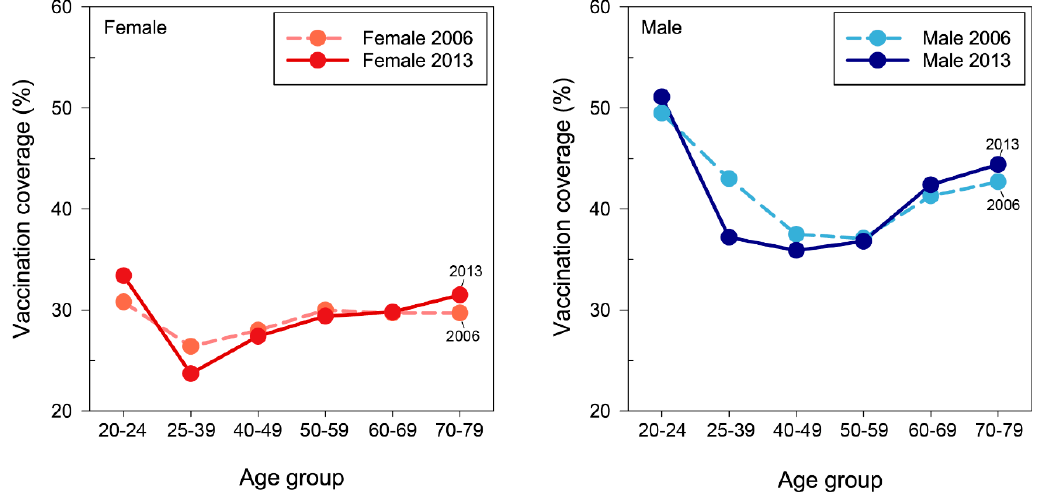
Figure 2. Tetanus vaccination coverage among adults aged between 20 and 79 years in Taiwan’s representative cohort at the beginning and the end of 8-year follow up by age and gender. (2006–2013, n = 771,443).